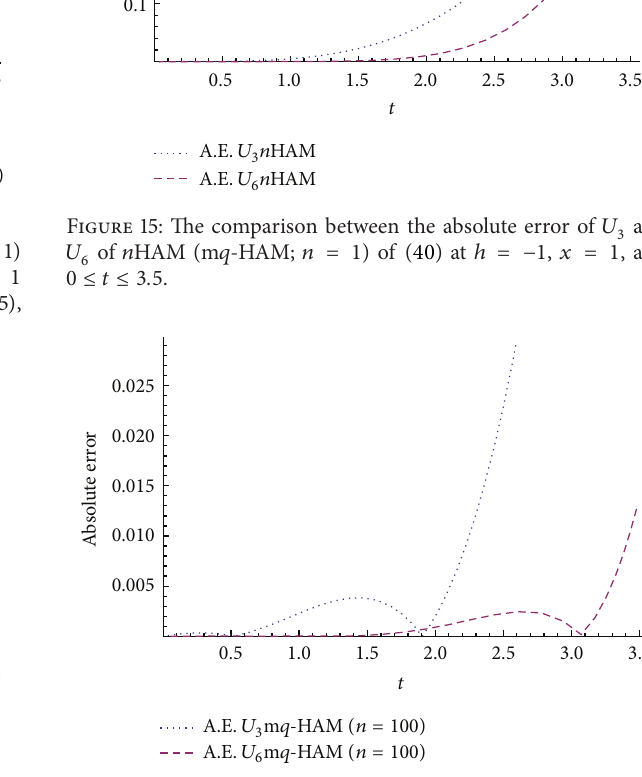
Figure 16: The comparison between the absolute error of 𝑈 3 and 𝑈 6 of m 𝑞 -HAM (𝑛 = 100) of (40) at ℎ = −79.5 , 𝑥 = 1 , and 0 ≤ 𝑡 ≤ 3.5